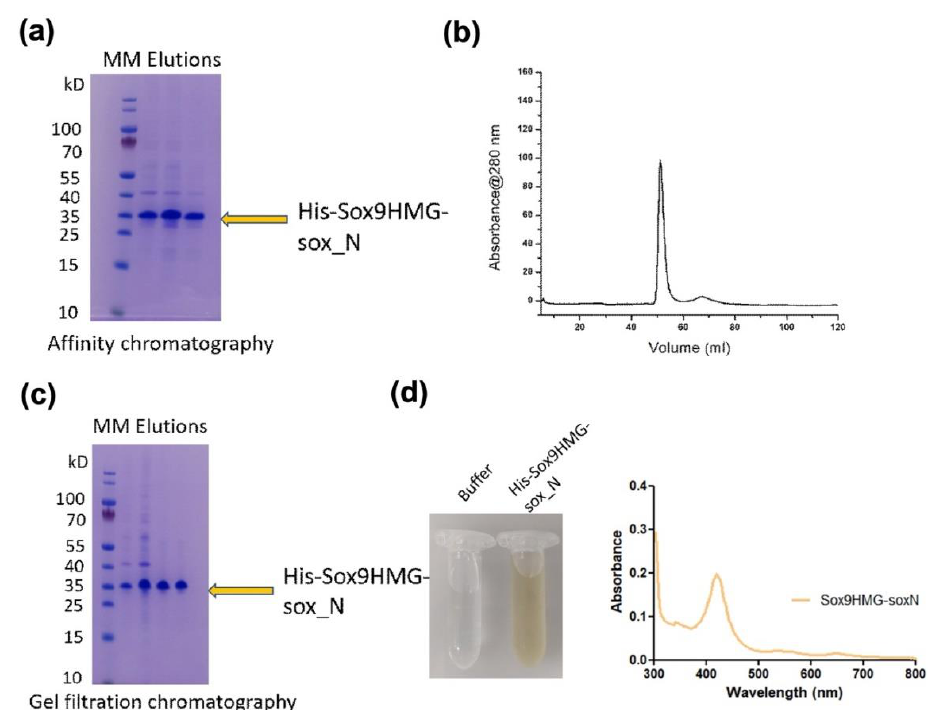
Figure 2. Purification and Uv-Vis spectroscopy of Sox9 construct . ( a ) Sox9HMG-sox_N construct (amino acids 1–173) was expressed in bacteria and purified using Ni-IMAC affinity chromatography, owing to having 6xHis at N-terminal of the construct. ( b ) Protein was concentrated and subsequently purified using gel filtration chromatography. The gel filtration chromatogram showed a homogenous and monodisperse peak. ( c ) SDS-PAGE of the gel filtration elution fractions corresponding to the Sox9HMG-sox_N construct. ( d ) Uv-Vis spectroscopic spectra of the purified Sox9HMG-sox_N showing absorption maxima between 400–450 nm. Buffer was used as a reference.